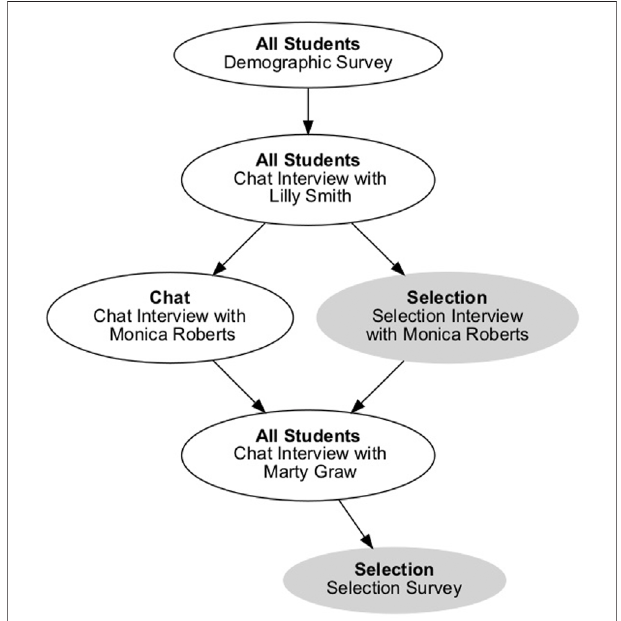
FIGURE 3 | The study tasks completed by the